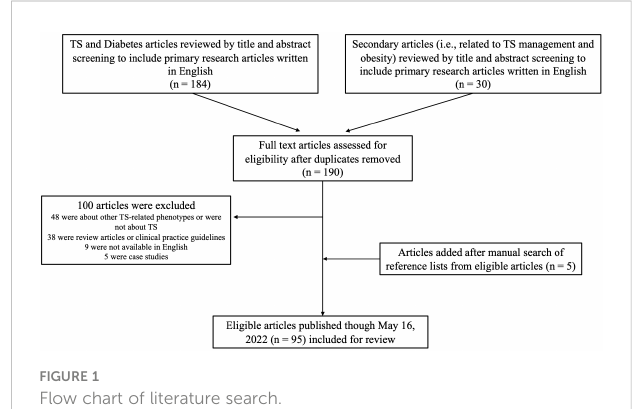
FIGURE 1 Flow chart of literature